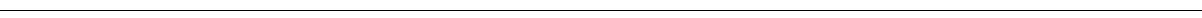
Fig. 1 Loss of B2M is associated with resistance in a patient treated with checkpoint blockade. a Treatment and sample collection timeline for Pat208. Row 1, computed tomographic (CT) images of right thigh taken at baseline, during response and relapse; row 2, CPB treatments (ipilimumab — anti-CTLA4, pembrolizumab — anti-PD1); row 3, clinical response while on treatment, with blue indicating regression and orange indicating progression; row 4, days elapsed with respect to the start of treatment; row 5, location of biopsies taken at the different time points. b Criteria used to identify potential drivers of resistance, were genes with multiple non-silent mutations and LOH that are dominant only during disease progression. Out of 248 mutations with adequate coverage across all samples (detection power ⩾ 0.9), only B2M mutations satis fi ed all criteria (upper panel). Fraction of cancer cells harboring two separate early frameshift mutations in B2M (p.Leu13fs and p.Ser14fs) detected in Pat208. Blue backgrounds indicate samples taken during disease regression, and orange backgrounds indicate samples taken during disease progression. Error bars indicate 95% con fi dence intervals as inferred by ABSOLUTE (lower panel, described in “ Methods ” section). c Illustration of the deletions locations on chromosome 15 overlapping the B2M locus found in Pat208, as well as the location of the two early frameshift mutations relative to the B2M gene (blue line); and the total copy ratios of target regions on chromosome 15 in each biopsy. Red dashed lines indicate an absolute total copy number of 2 as inferred by ABSOLUTE. A deleted region overlapping the B2M locus is seen in all relapse samples (light orange background). d Samples were stained with an antibody cocktail for melanoma cells (mel.cocktail) using anti-melanosome (HMB45), anti-MART-1/melan A and anti-Tyrosinase, to discern melanoma cells from normal cells; or with an antibody speci fi c for B2M. Colored boxes indicate B2M expression scores: B2M scoring was estimated by using four different levels of expression in the tumor fraction: minimal, 0 – 10%; low, 10 – 50%; intermediate, 50 – 80%; and high, 80 – 100%, B2M expression in the tumor fraction. Original magni fi cation